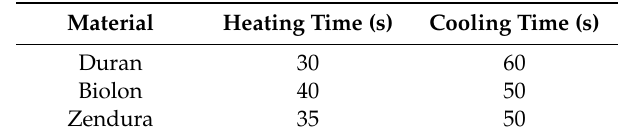
Table 1. Heating and cooling time adopted during the thermoforming process. The cooling was carried out at room temperature and at a pressure of 4 bar.